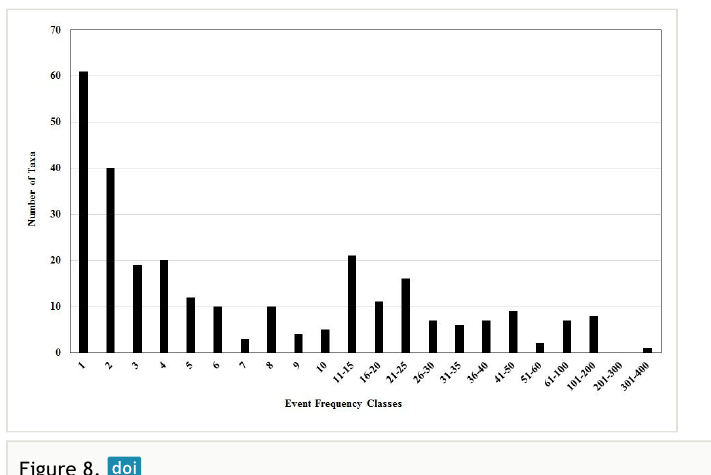
Figure 8. Number of stone fl y taxa occurring in site/date event frequency classes.